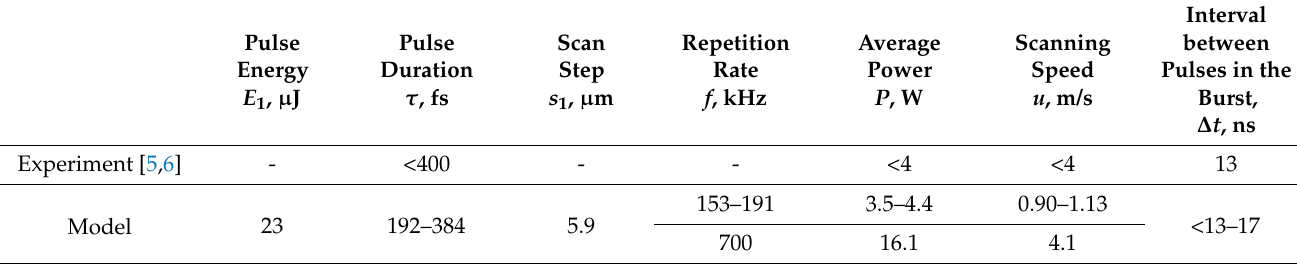
Table 6. Comparison of experimental [5,6] and theoretical values of the parameters τ , P , u and ∆ t for the smooth LFC of chemically tempered Corning ® Gorilla ® Glass